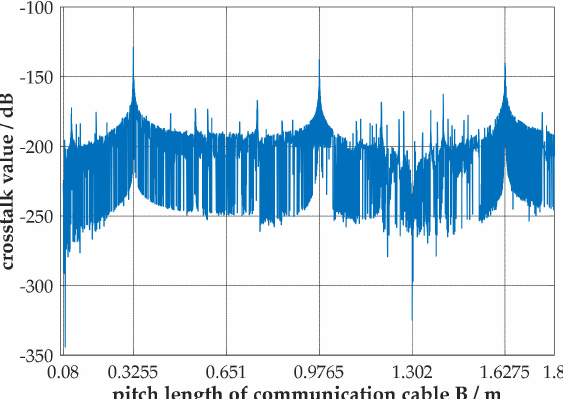
Figure 10. The changing pattern of far − end crosstalk value versus pitch